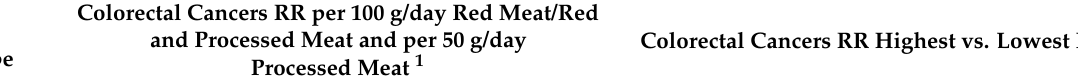
Table 3. Meta-analyses examining the relative risk (RR) and 95% confidence interval of colorectal cancers in relation to consumption of red and processed